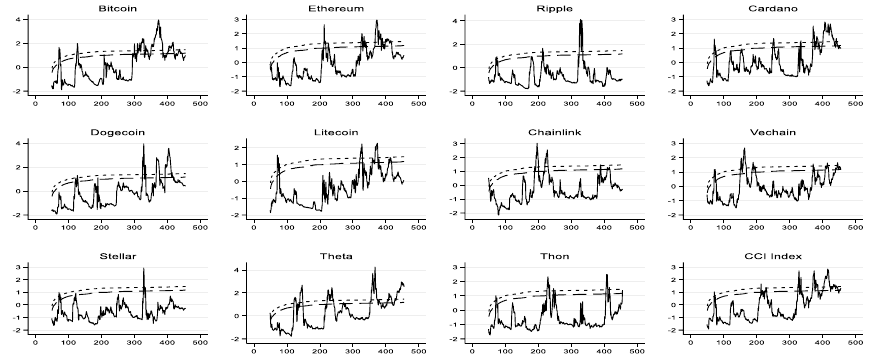
Fig. 1 PSY bubble graphs. The small dashed line indicates the 95 percent level of critical value, while the large dashed line presents the 90 percent level of the critical value of the bootstrapped Dickey-Fuller test statistics. The straight line represents the BSADF test statistics